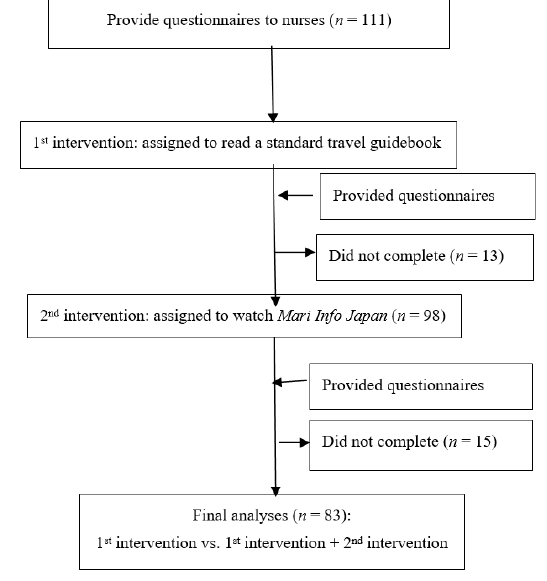
Figure 1. Trial profile.